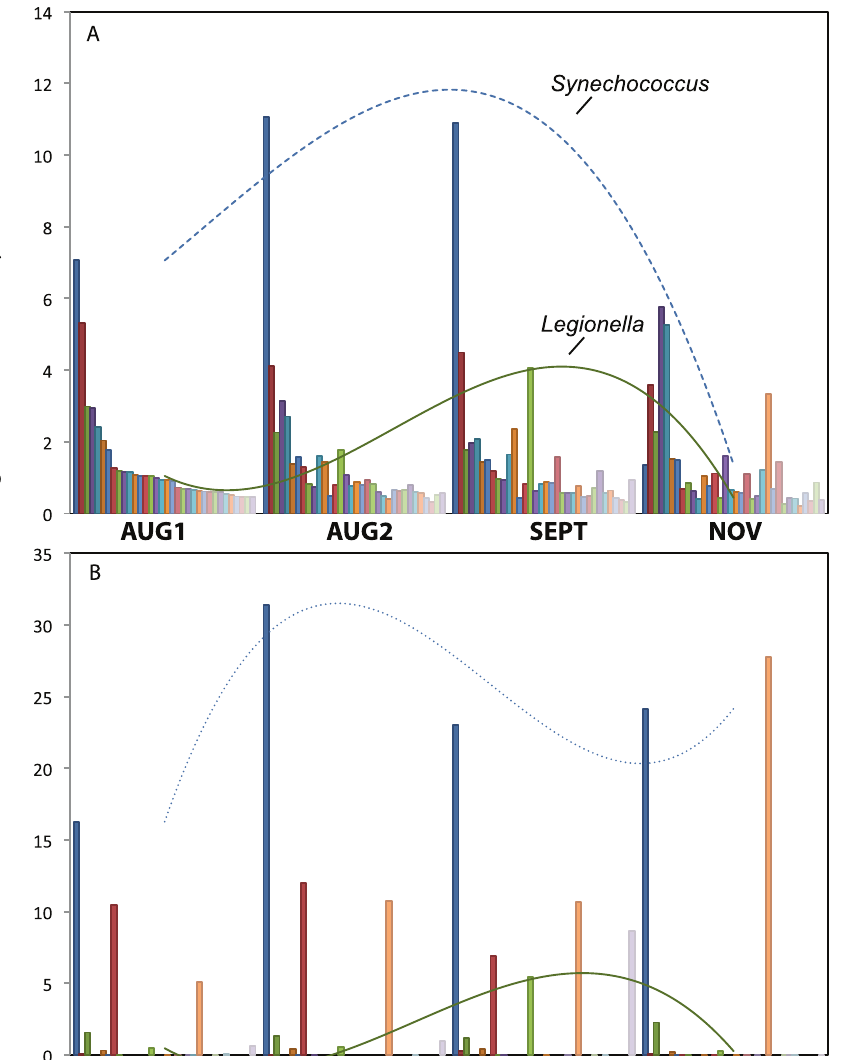
Figure 4. Individual genera abundance shifts over time based on 16S and metagenomes. Genus-level taxonomic trends for a subset of genera identified within the metagenomic contigs (A) and 16S rRNA amplicon (B) datasets, based on NCBI taxonomy, are shown. The lines represent the general temporal trends of two genera, Synechococcus and Legionella , in each dataset.